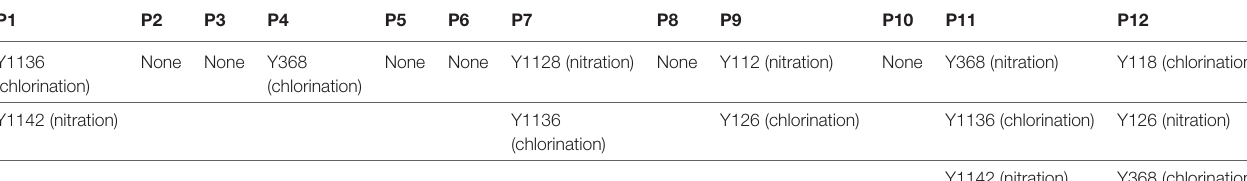
TaBle 1 | Modification sites of factor H in patients with active ANCA-associated vasculitis detected by mass